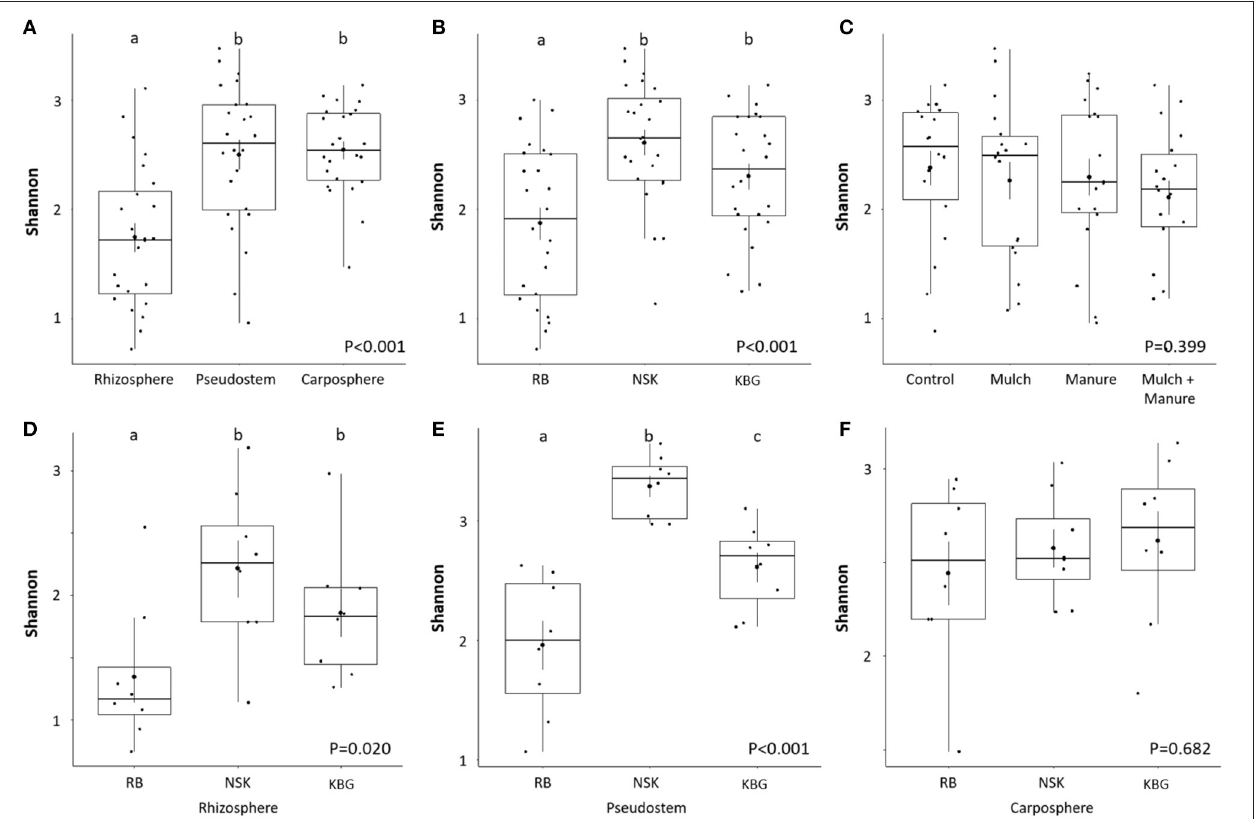
FIGURE 2 | Shannon indices of gammaproteobacterial diversity in different microhabitats (A) , smallholder farms (B) , organic soil amendment treatments (C) , and for different microenvironments in different smallholder farms (D–F) at a genetic similarity level of 97%. Significant differences ( p ≤ 0.05, ANOVA with Tukey-HSD post hoc test) within tested factors are indicated by different letters above the boxplot. Smallholder farms are abbreviated with RB, NSK, and